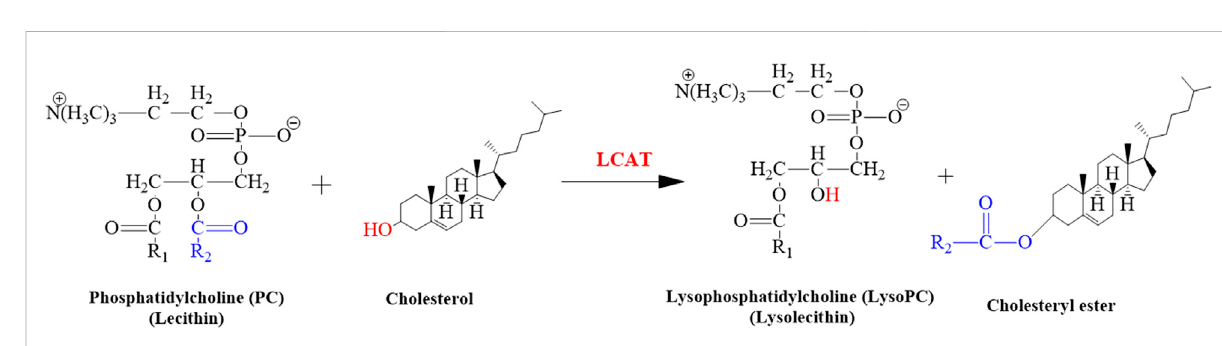
FIGURE 11 Illustrated the conversion of cholesterol into cholesteryl ester. This reaction is catalyzed by LCAT.